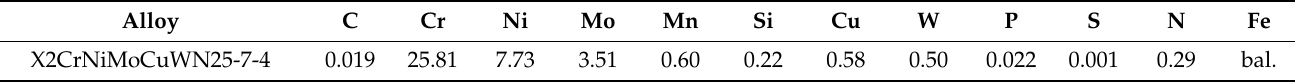
Table 1. Chemical composition of the feedstock determined using S-OES (in mass %).